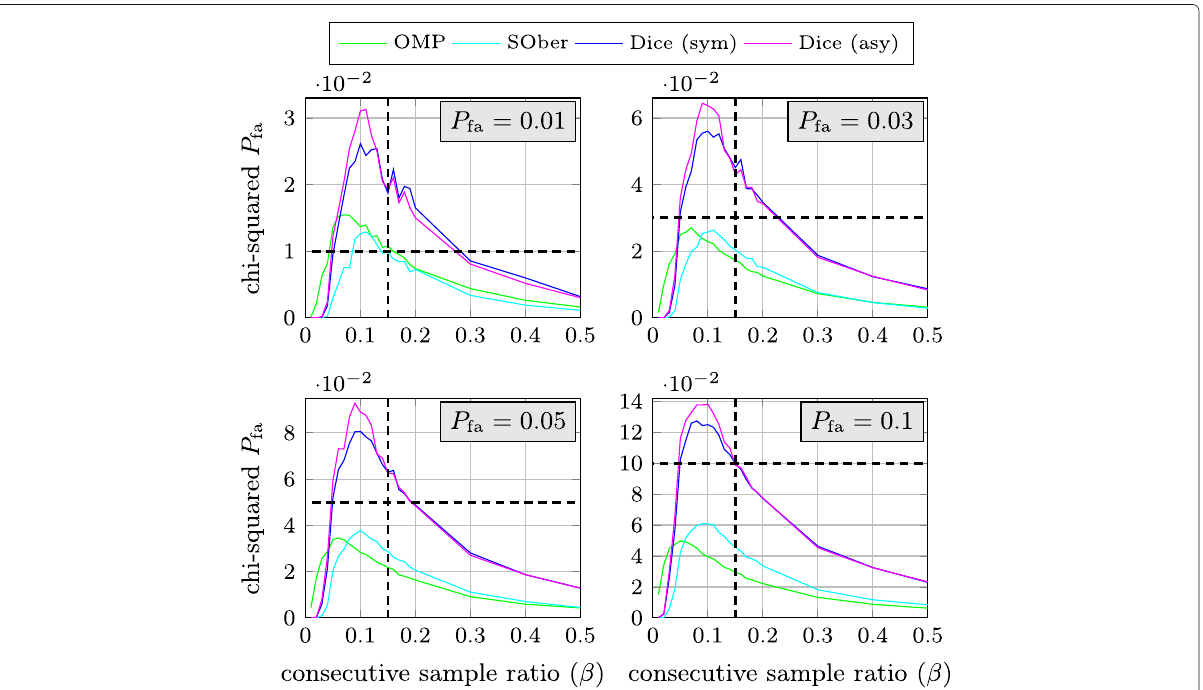
Fig. 3 False alarm rate that has to be selected according to the chi-squared distribution to obtain different actual false alarm rates over the consecutive sample ratio